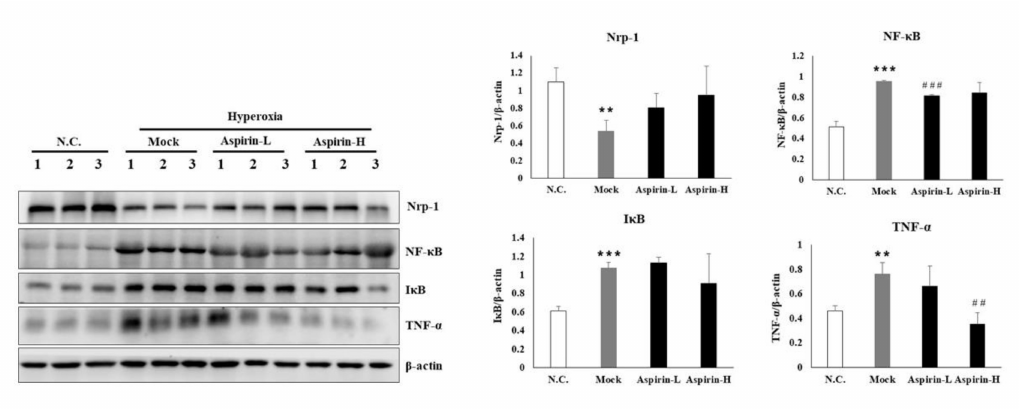
Figure 7. Protein expression of inflammatory signaling in NF- κ B–luciferase transgenic mice after induction of hyperoxia for 72 h in the normal control (NC), mock, aspirin-L and aspirin-H groups. The reported values are expressed as the mean ± SEM ( n = 6). ## p < 0.01, ### p < 0.001 vs. NC group. ** p < 0.01, *** p < 0.001 vs. mock